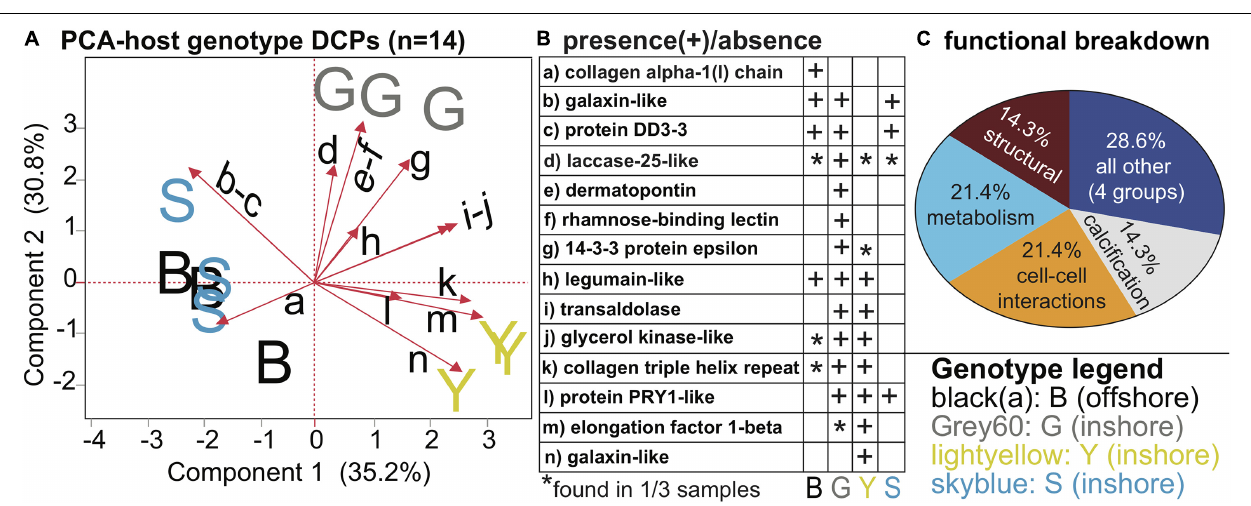
FIGURE 3 | Temperature-sensitive Orbicella faveolata proteins. A PCA (A) with the eight proteins whose concentrations differed significantly across temperatures (temp.); “C,” “H,” and “V” correspond to c ontrol (30 ◦ C), h igh (32 ◦ C), and v ery high (33 ◦ C) temperatures, respectively. The black, small-font, lower-case letters over the biplot rays correspond to the row where the respective data for each protein have been displayed in (B) . A functional breakdown of the proteins can be found in (C) . For details on these eight proteins, please see Table 3 and Supplementary Tables 2, 4 .